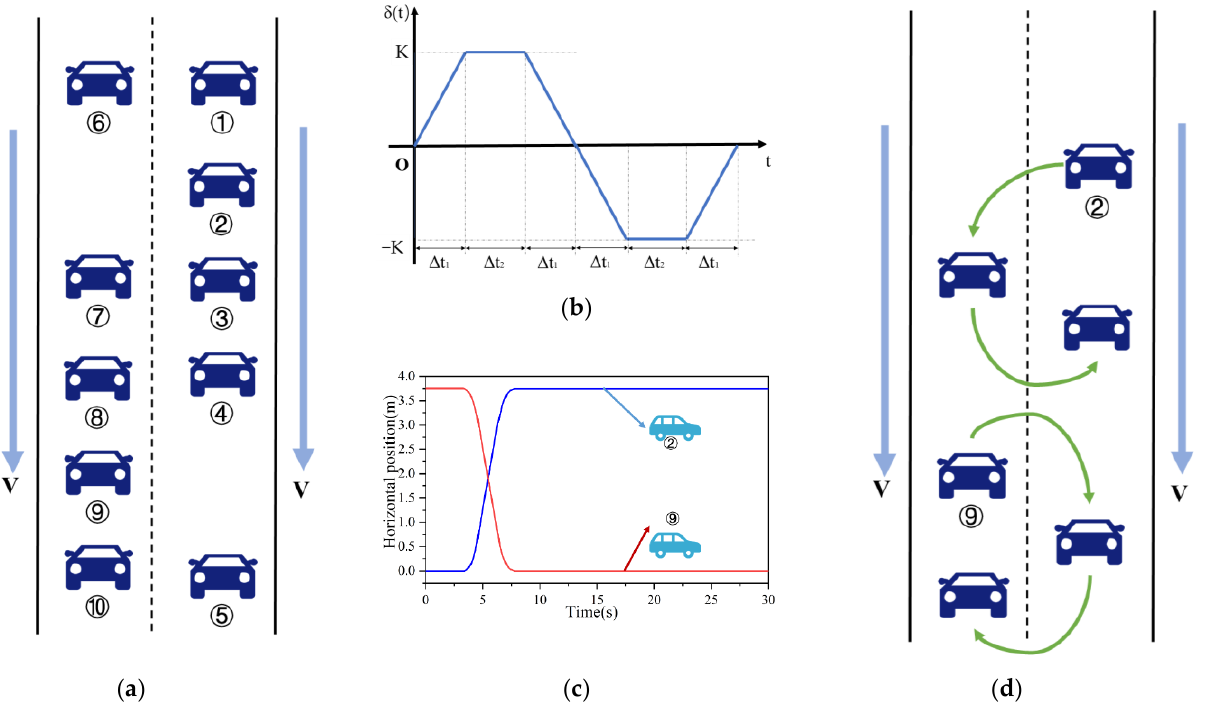
Figure 8. ( a ) Lane change simulation scenario; ( b ) Lane change steering angle model; ( c ) Lateral position curve for lane change motion; ( d ) Car 2 and Car 9 for lane change simulation.